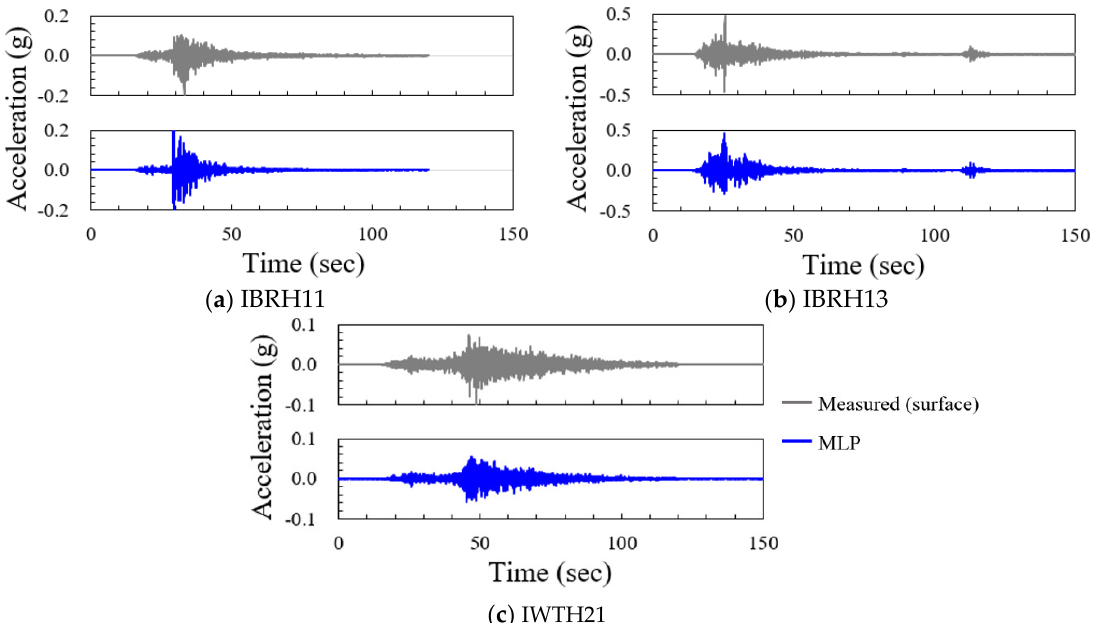
Figure 6. Earthquake acceleration measurements and acceleration predictions by MLP.